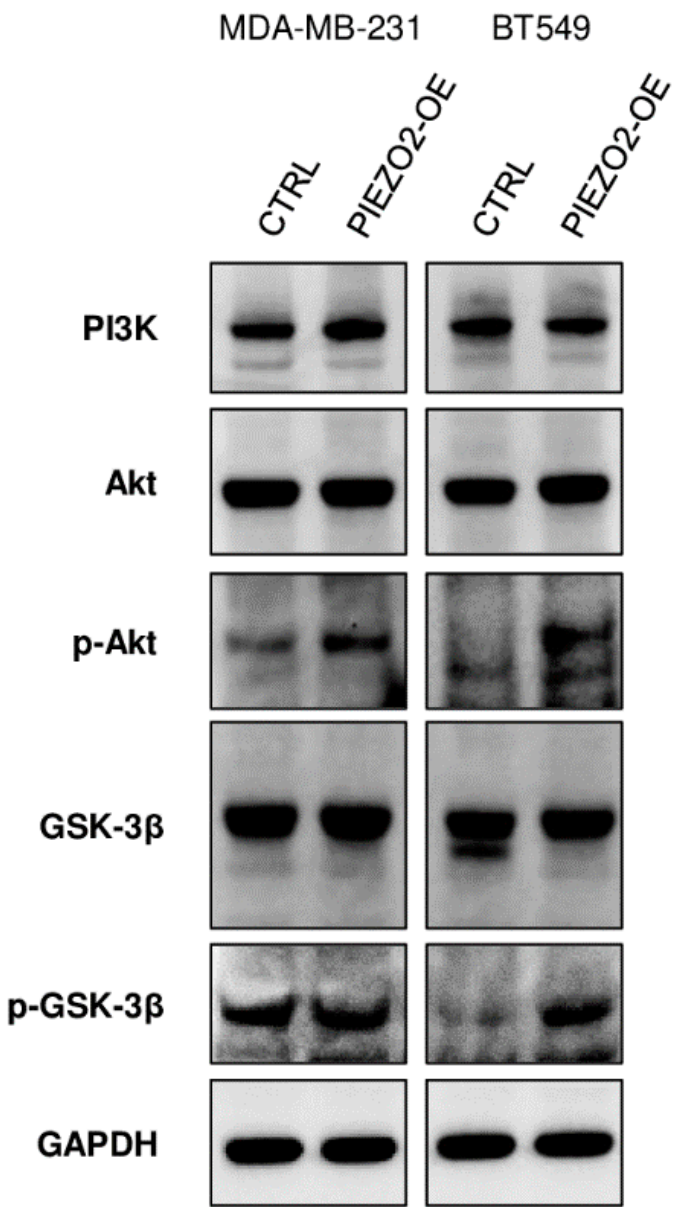
Figure 5. Overexpression of PIEZO2 showed activation of Akt/GSK-3 β pathway. Western blotting of PI3K, Akt, p-Akt, GSK-3 β , p-GSK-3 β , and GAPDH in control (CTRL), and PIEZO2 overexpressed (PIEZO2-OE) in MDA-MB-231 and BT549 cells.